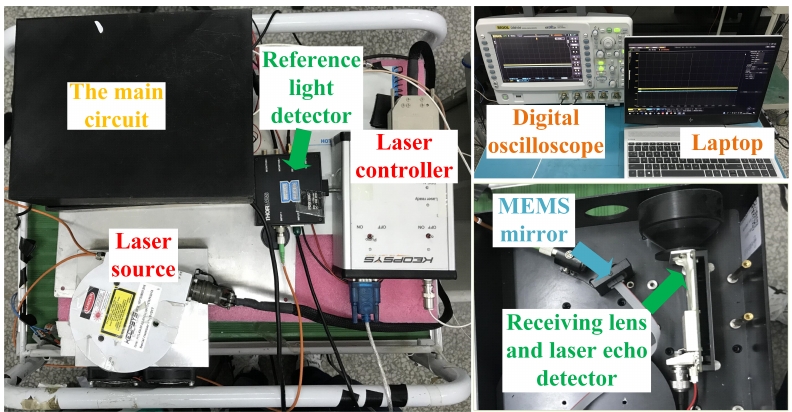
Figure 3. Experimental equipment